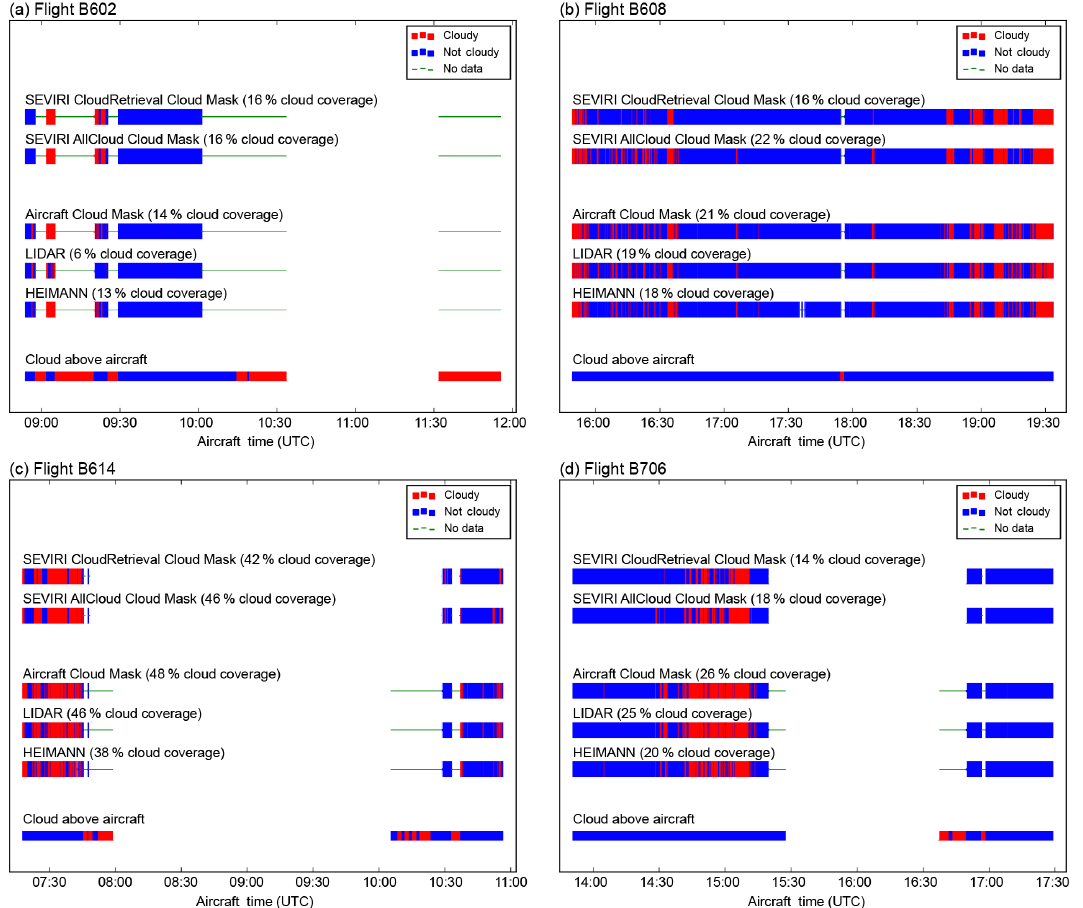
Figure 3. Comparison of CloudRetrieval (SEVIRI pixels fully cloud contaminated) and AllCloud (partially cloud-contaminated SEVIRI pixels also included) cloud masks against the aircraft cloud masks for flights (a) B602, (b) B608, (c) B614, and (d) B706. Percentages show the amount of cloudy points (red) as a fraction of the total (red+blue) points for which a cloud flag has been assigned. Gaps in the data (green) can be attributed to either the filtering of cloud detected above the aircraft, aircraft altitudes of < 4500m, or missing points in the raw data. The BBR-derived filter for cloud above the aircraft is also